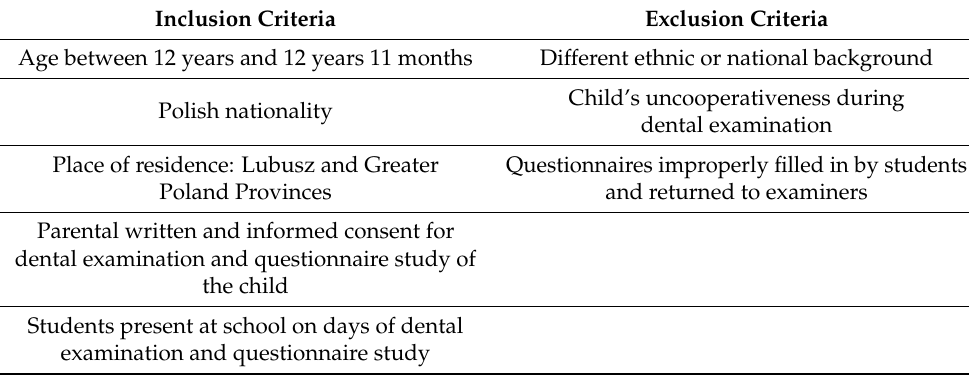
Table 1. The inclusion and exclusion criteria for 12-year-old students participating in the study.